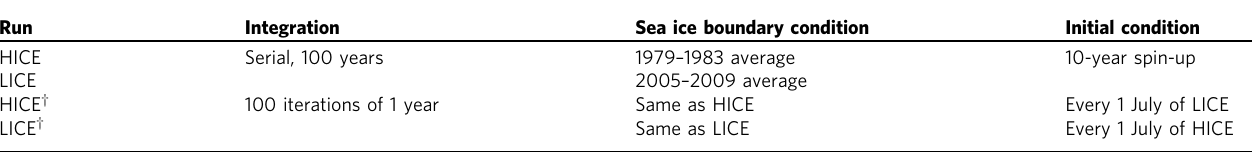
The SST boundary condition is commonly de fi ned as the climatological mean of the 1981 – 2010 period for all